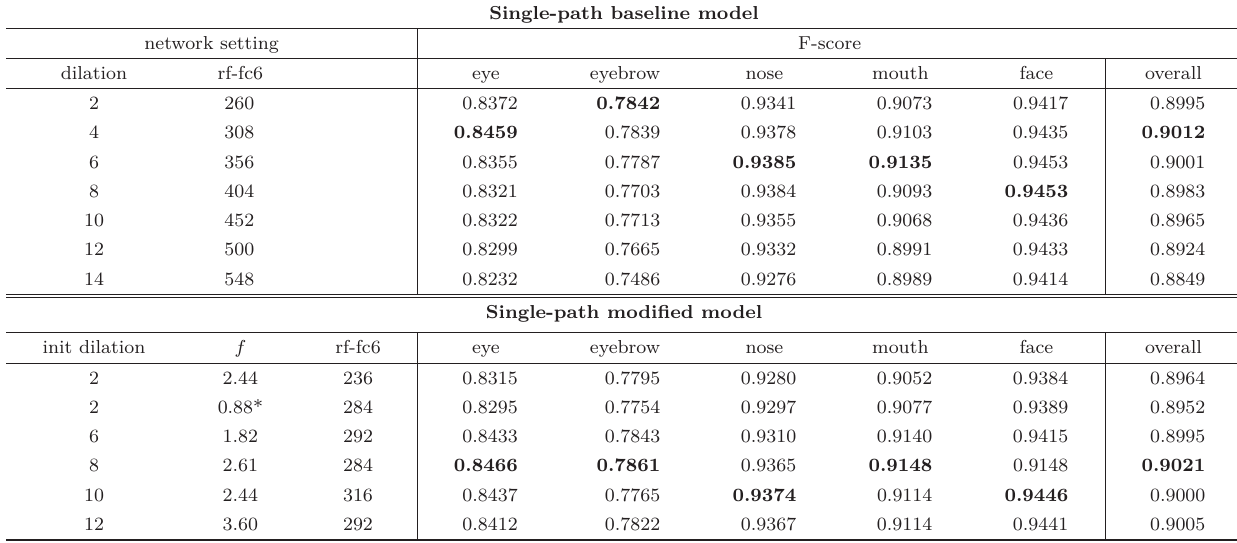
Table 2 Quantitative evaluation of baseline models and modified models using the Helen dataset. Key: dilation : dilation values in the fc6 layer. rf-fc6 : the extent of the receptive field in the fc6 layer. ∗ : the inflation factor starts being updated after 10 , 000 iterations in training Single-path baseline model